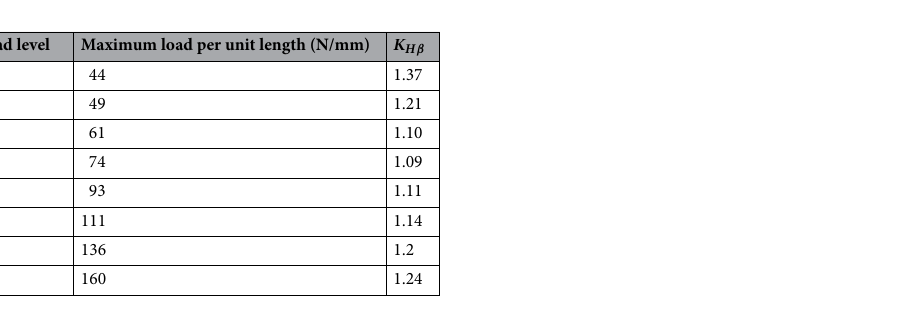
Table 13. Face load factor of SGS 1 in modified gearbox after micro-geometry modification according to load level in LDD.